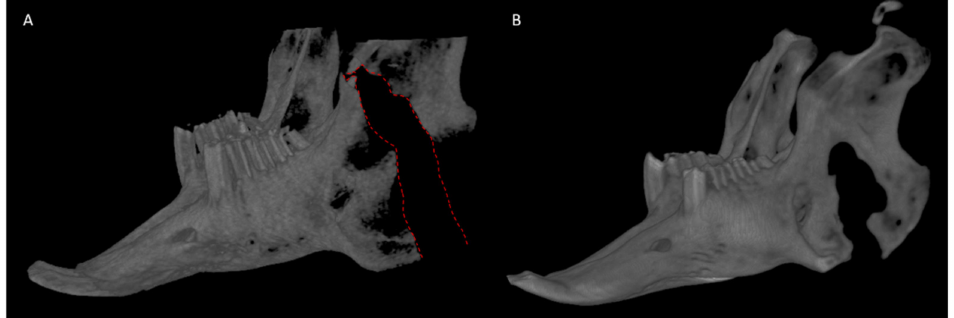
Figure 11. Reconstructed 3D CBCT volumes of rabbit narrow gap CRO. ( A ) Unhealed defect at 1 week; the red dashed line demonstrates the defect that extends through the superior ramus. ( B ) The same mandible after 10 weeks, the defect region has healed in a bony union with a concomitant return of normal incisor morphology and symmetry to the right side. CBCT: cone beam computed tomography, CRO: complete ramus